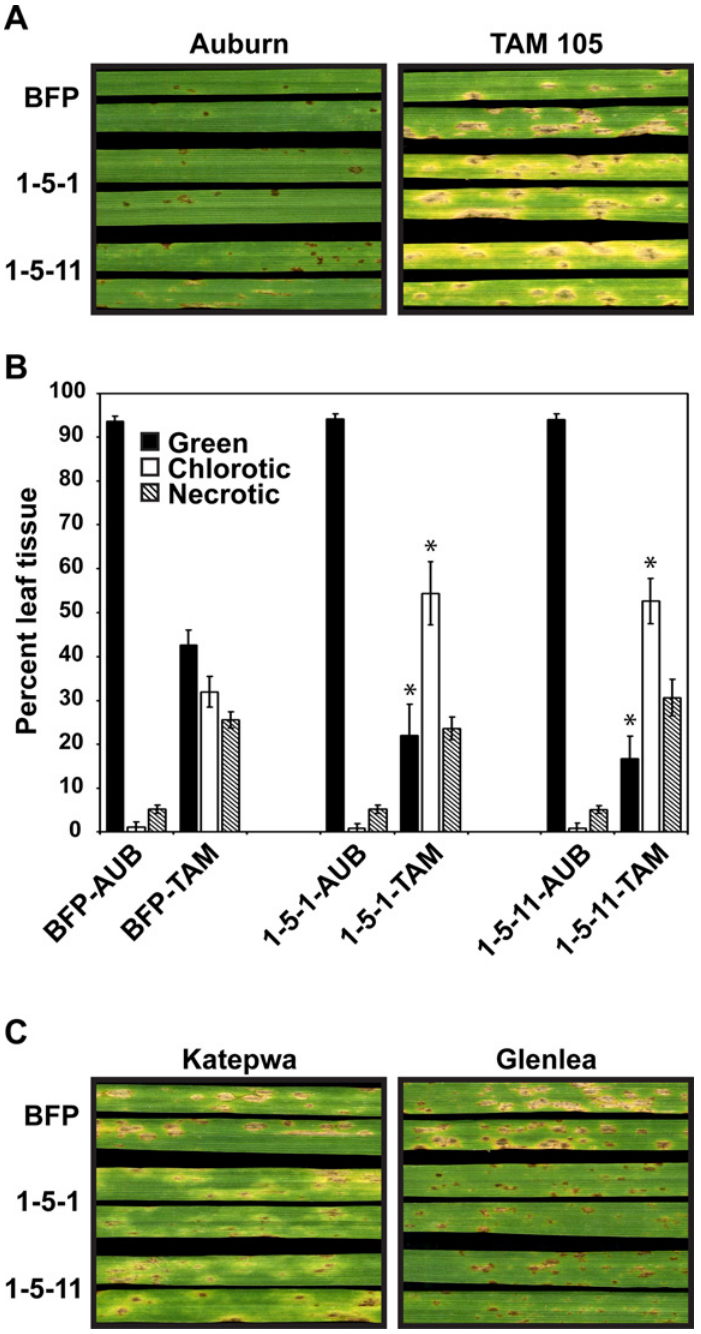
Fig 3. Symptom development induced by BFP and BFP Δ toxA isolates on ToxA-sensitive and -insensitive cultivars. The ToxA-insensitive and -sensitive cultivars, ‘ Auburn ’ and ‘ TAM 105 ’ , respectively, were inoculated and the symptoms (A) monitored and (B) quantified (chlorosis and necrosis). Bars represent means of values from three leaves per experiment from three independent experiments (nine total), error bars represent standard error, and * indicates a statistical difference from BFP as measured by a Student ’ s t-test ( P < 0.05). (C) Symptom development on two additional ToxA-sensitive cultivars, ‘ Katepwa ’ and ‘ Glenlea ’ . Leaves were harvested 5 days post